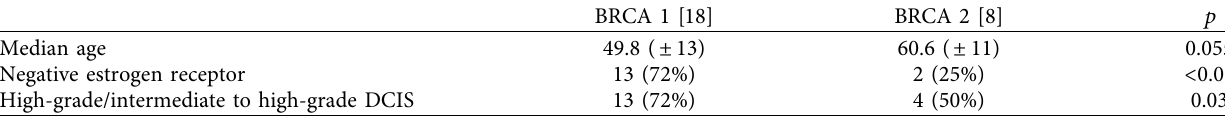
Table 1: Age distribution, DCIS grade, and hormone receptors.